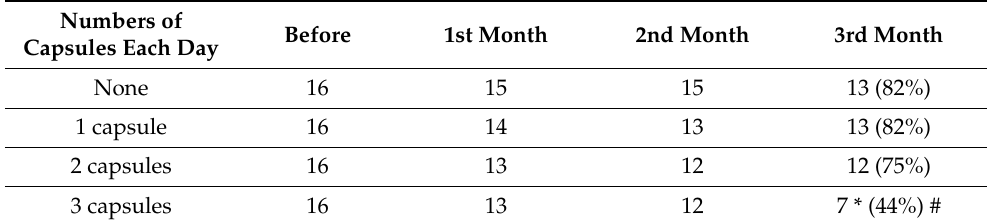
Table 2. The changes in ocular floaters before and after taking the mixed fruit enzyme capsules over a three-month period in Experiment 2.